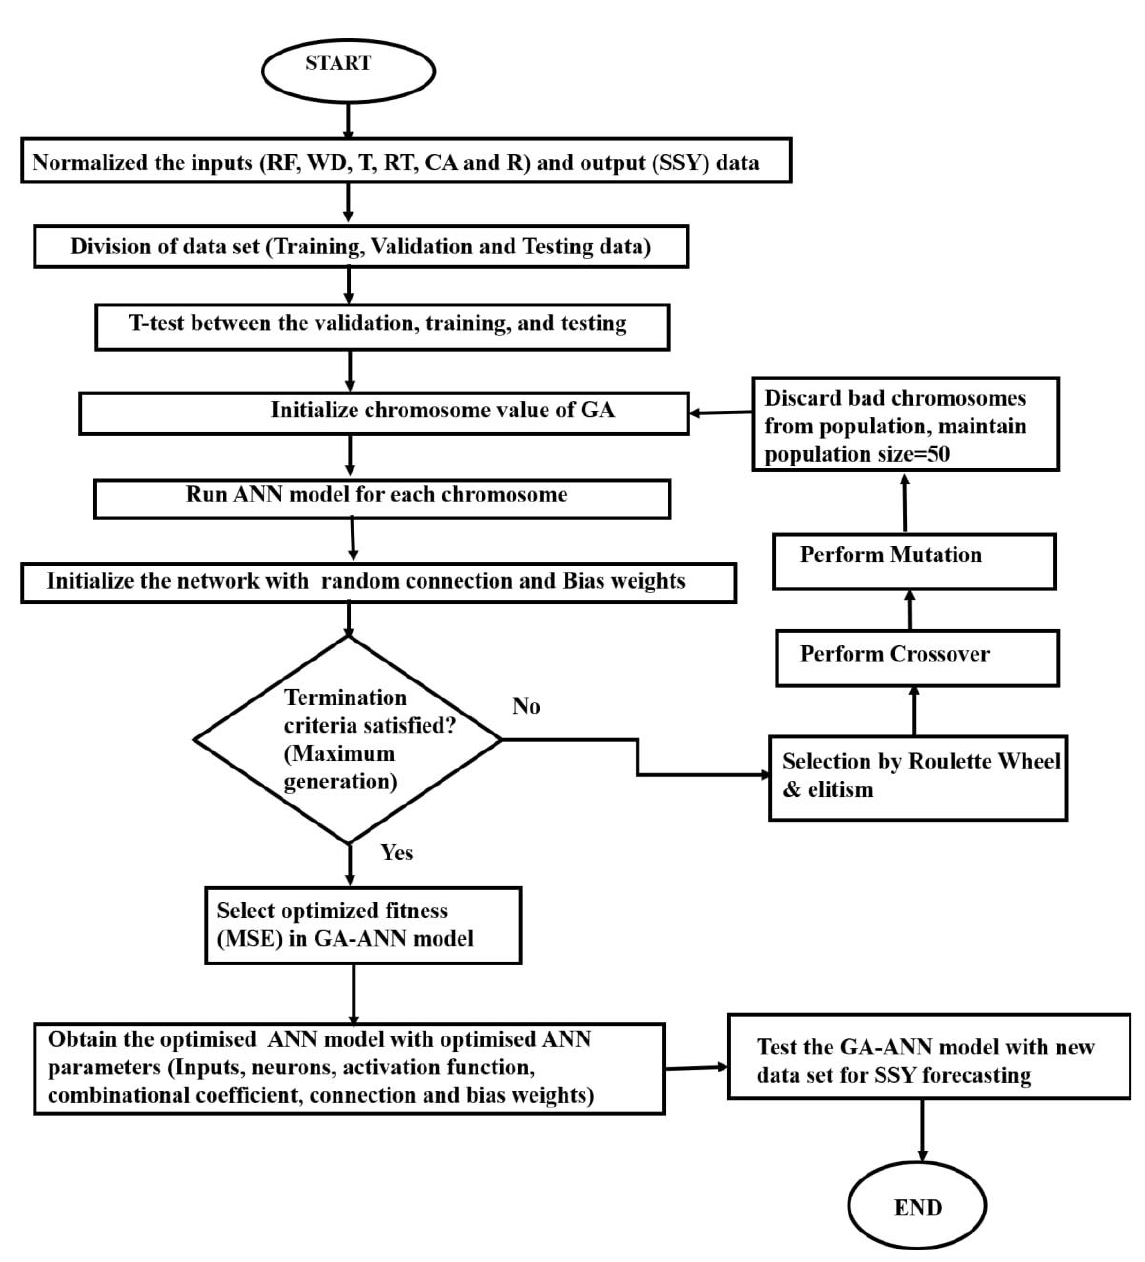
Figure 2. Flow chart of hybrid GA-based ANN model.